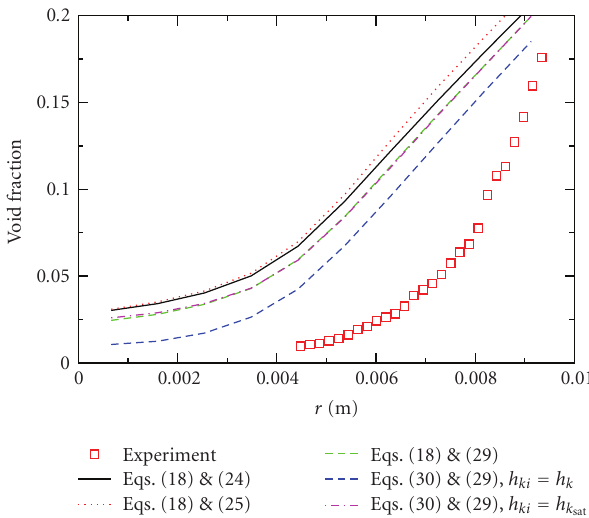
Figure 1: comparison of the di ff erent models on the void fraction profile.